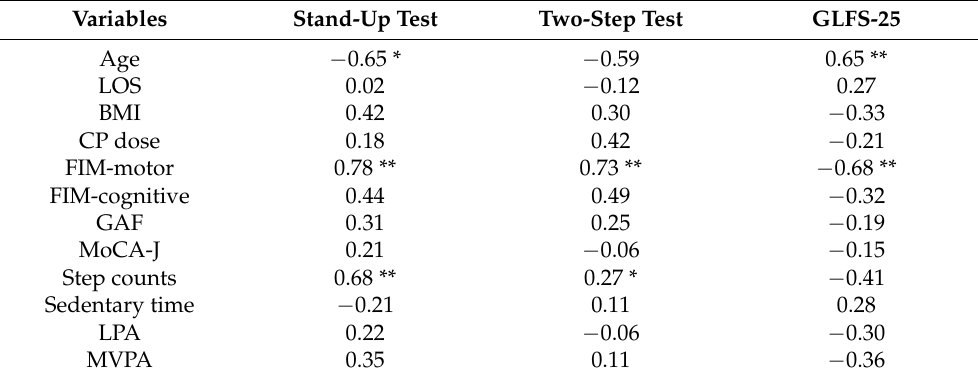
Table 5. Correlations between the stand-up test, two-step test, and GLFS-25 scores and measured variables in